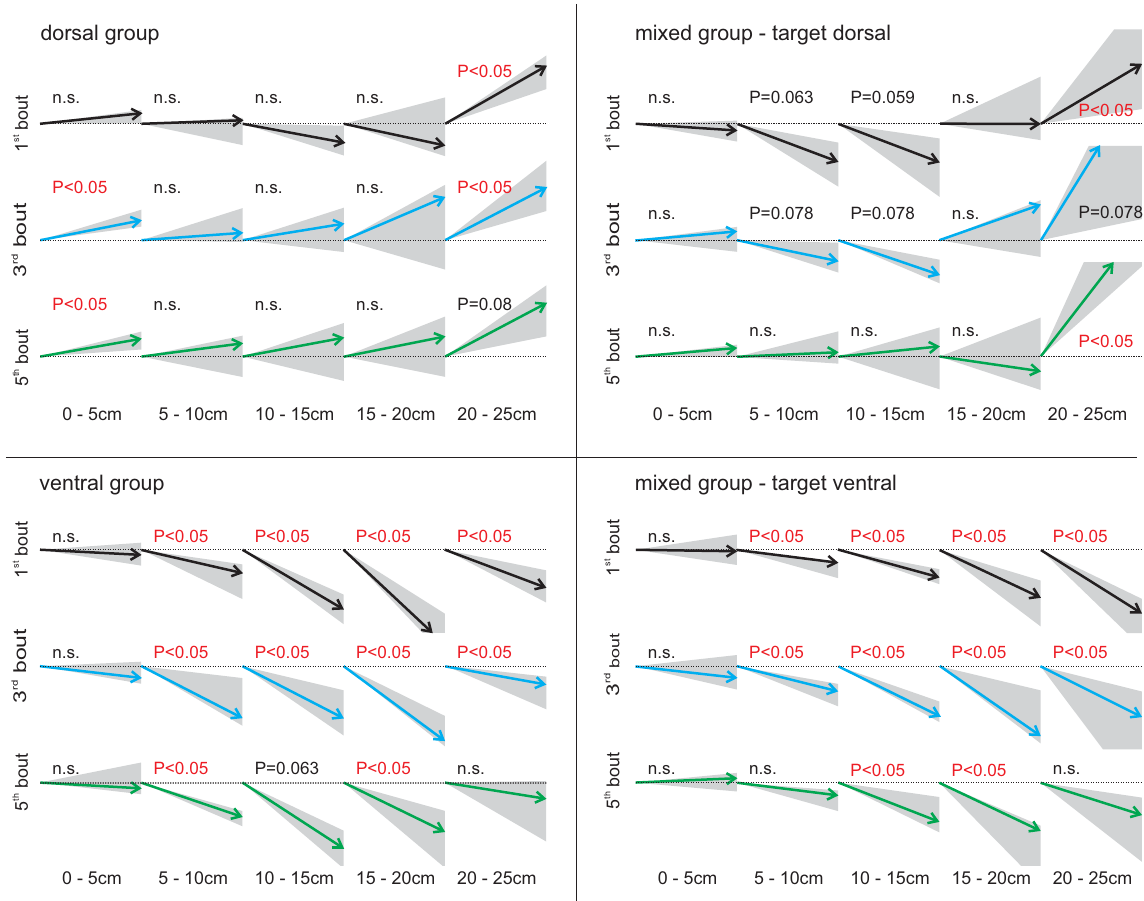
Figure 5. Flight structure of the three treatment groups. Median flight angles of different phases in the bee’s flights crossing the experimental arena from the entrance (0 cm) to 25cm from the entrance (i.e. 5cm from the targets). For all four search situations the first (black arrows), the third (blue arrows) and the fifth foraging bout (green arrows) are shown (N=7 – videos for the lateral-view camera were incomplete for some of the 9 tested individuals). In the mixed group the flight number refers to number of foraging bouts absolved with the particular target location (top row or bottom row) and not to the total number of bouts the bee has absolved (all foraging bouts regardless of the target location). Arrows: median flight angles; grey area: first to third quartile; statistics: one-sample Wilcoxon test against 0° (flight without significant trend of changing flight